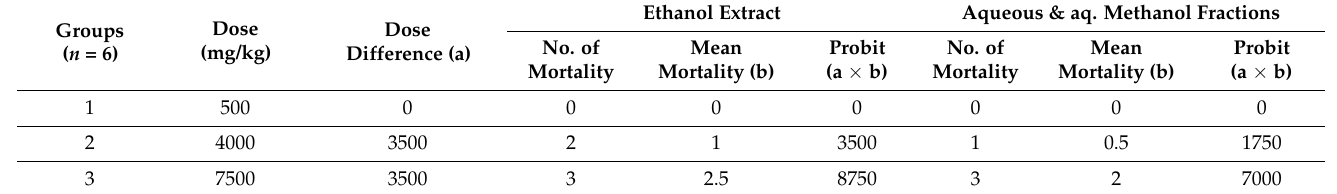
Table 7. Acute toxicity assay of X. spinosum ethanol extract, aqueous and aq. Methanol fractions in mice.